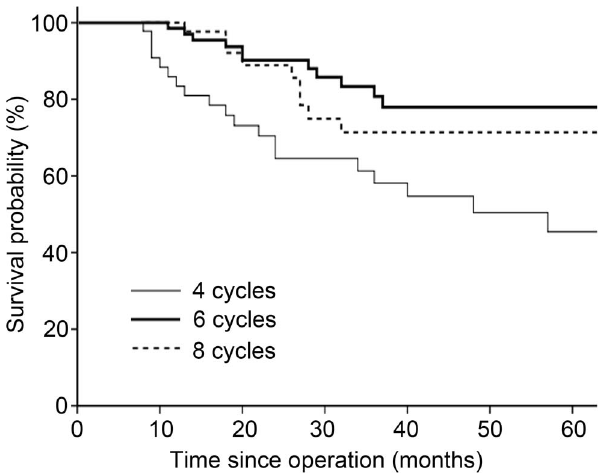
Figure 4. Kaplan-Meier survival curves by number of treatment cycles in patients who underwent D2 gastrectomy.